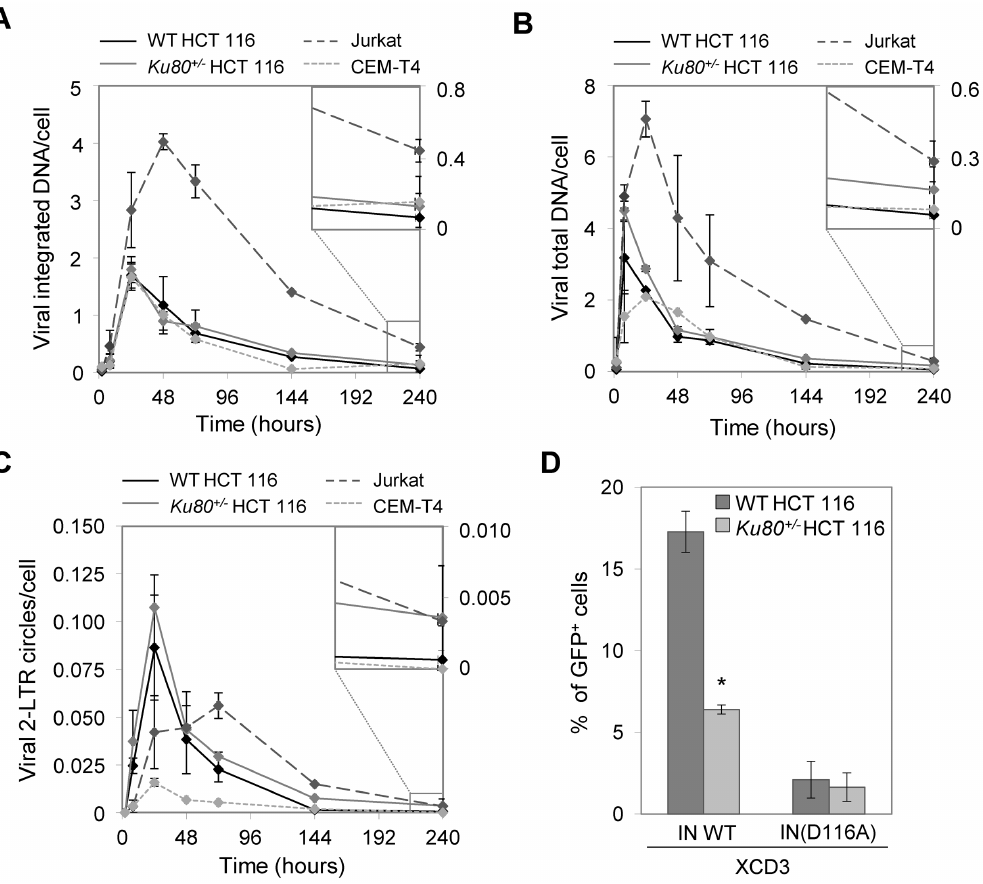
Figure 4. The haplodepletion of Ku in target cells has no effect on HIV-1 (pre-)integrative steps but requires viral integration to modulate HIV-1 expression. ( A–C ) Wild-type (WT) and Ku80 + / 2 human colon carcinoma HCT 116 cells as well as the human T lymphoid leukemia Jurkat and CEM-T4 cell lines were transduced with the same volume of XCD3 (m.o.i , 0.2). At the time specified from transduction, the cells were subjected to quantitative PCR (Q-PCR) assays to quantify the viral DNA (vDNA) species. The copy number of the integrated vDNA ( A ), the total vDNA ( B ) and the 2-long terminal repeat (LTR) circular forms of vDNA ( C ) per cell for each cell line are reported (mean 6 SEM; n =2). The last data point (240 h post-transduction) is shown at higher magnification. ( D ) WT and Ku80 + / 2 HCT 116 cells were transduced for 48 h either with XCD3 or its integrase-defective derivative, XCD3 IN(D116A) (at a m.o.i. =0.15), followed by cytofluorometry-mediated assessment of the percentage of green fluorescent protein-positive (GFP + ) cells. One representative experiment of at least 2 independent observations yielding similar results is represented (mean 6 SD; *, p , 0.05).